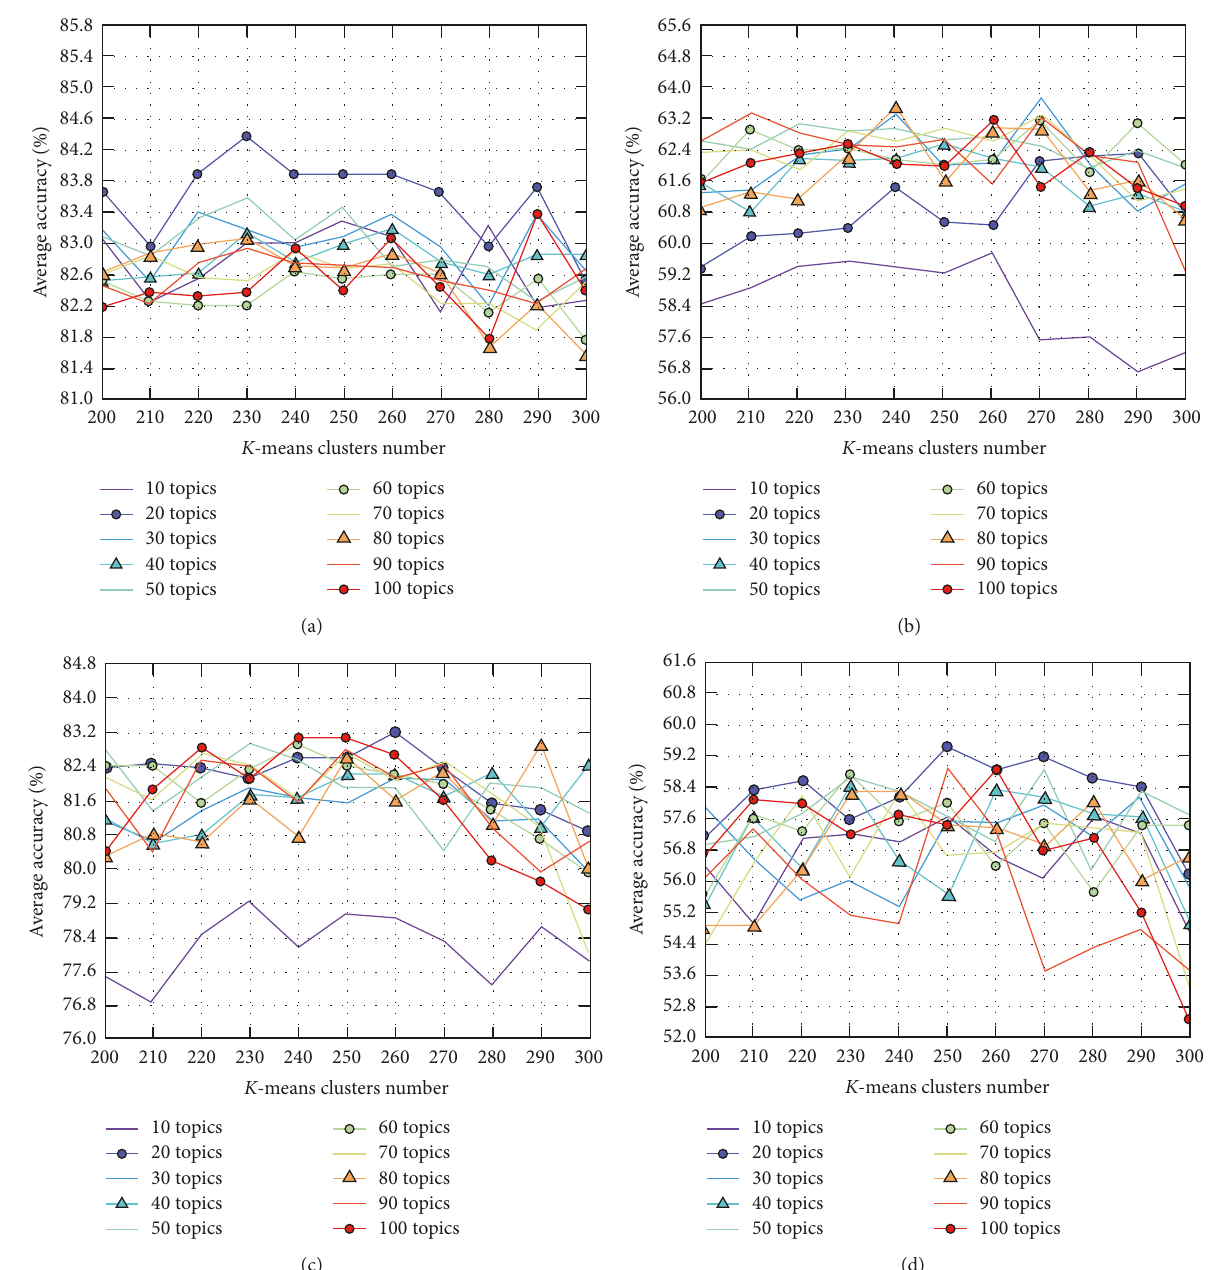
Figure 14: Average accuracy of (a) FrameDiff GridBlock Kmeans , (b) MultiCue GridBlock Kmeans , (c) FrameDiff GridIntersect Kmeans , and (d) MultiCue GridIntersect Kmeans , with 𝐾 ranging from 10 to 100 and 𝑐 ranging from 200 to 300.